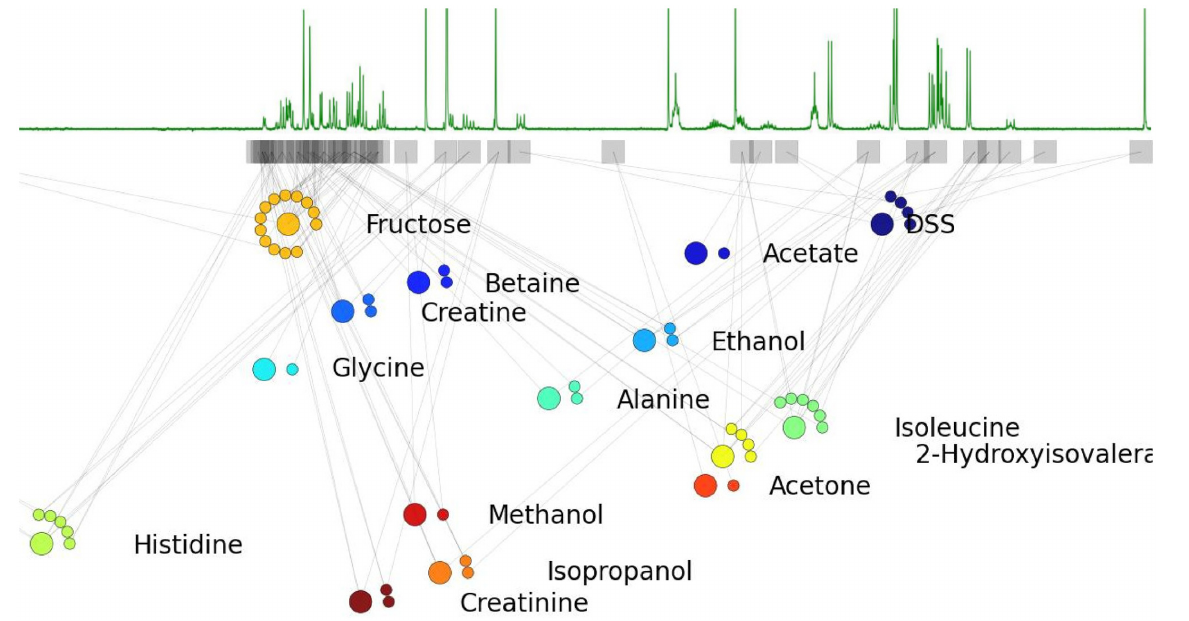
Fig 4. The factor-graph associated with a simple NMR spectrum. The factor-graph for a library of 15 compounds is shown immediately below an associated NMR spectrum. Each factor is represented by a square and each variable using a circle. Concentration (larger circles) and shift variables (smaller circles, beside the associated concentration) corresponding to each compound appear together. The position of each factor f I position in the plot corresponds to the center of the corresponding block X I .